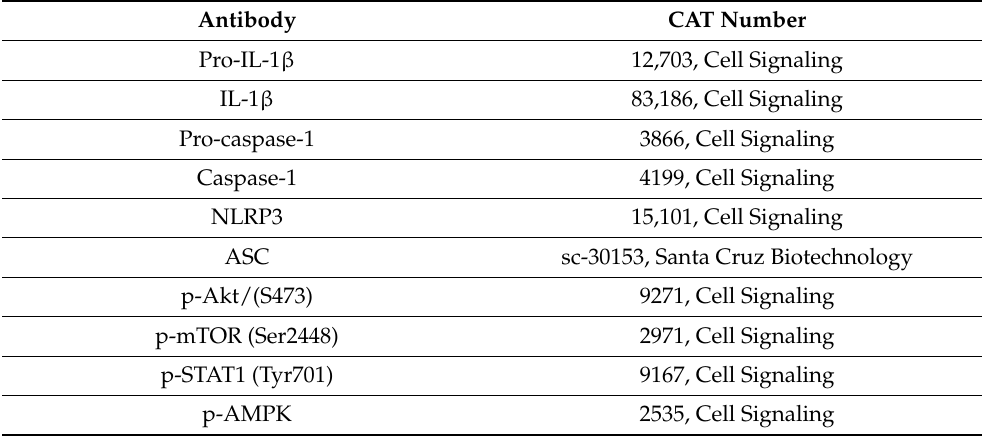
Table 2. List of the used